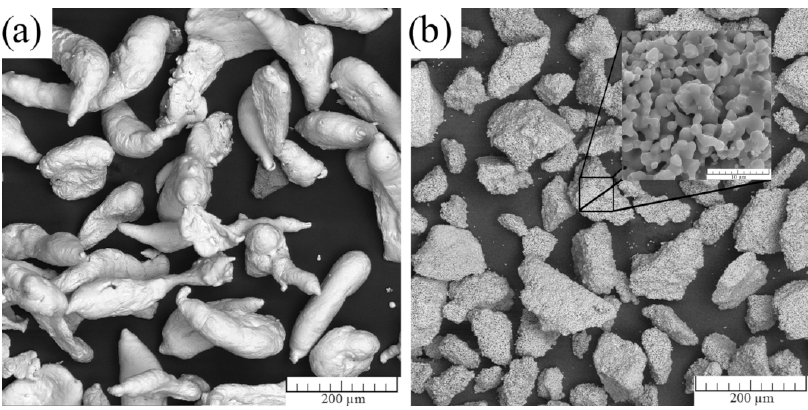
Figure 2. Morphology of the initial powders: ( a ) zinc and ( b ) hydroxyapatite.